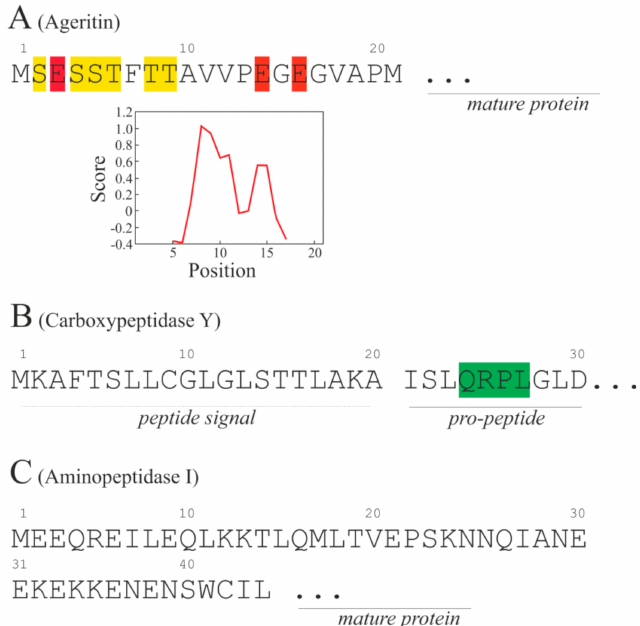
Figure 9. N -terminal amino acid signal peptide of Ageritin ( A ) and both N -terminal sequence of Carboxypeptidase Y ( B ; AC: P00729) and Aminopeptidase I ( C ; AC: P14904) from yeast implicated in vacuolar intracellular pathway. In A, the Kyte–Doolittle–Hydropathy plot of Ageritin N -terminal signal peptide is also reported. In yellow are highlighted tyrosinyl and serinyl residues, in red glutamyl residues. In green consensus amino acid